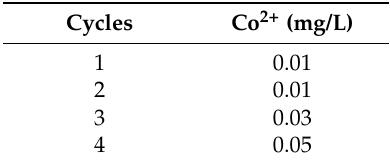
Figure 8. ( A ) The reusability of the CoMgAl-LDH catalyst; ( B ) ln(C/C 0 ) versus reaction time based on the effect of recycle reaction; ( C ) k obs for phenol degradation at various cycles. Table 2. Co 2+ leaching of CoMgAl-LDH after each cycle.